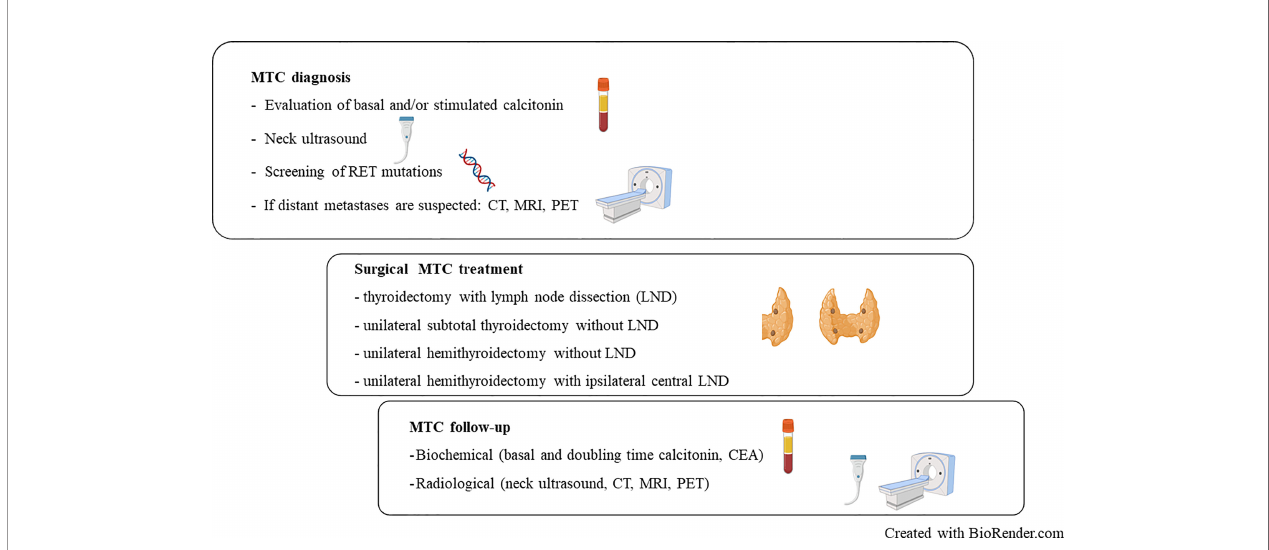
FIGURE 1 | Summary overview of diagnosis, treatment and follow-up procedure in medullary thyroid carcinoma (MTC). RET, REarranged during Transfection; CT, Computerized Tomography; MRI, Magnetic Resonance Imaging; PET, Positron Emission Tomography; CEA, Carcinoembryonic antigen; LND, Lymph Node